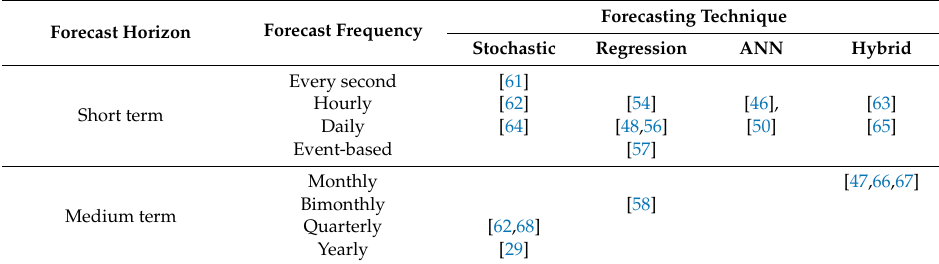
Table 3. Summary of the studies in water demand